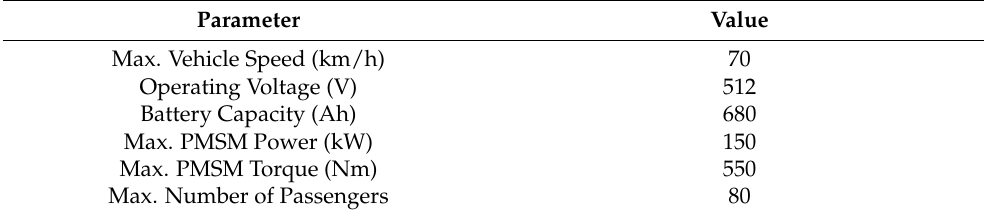
Table 1. Characteristics of the modeled